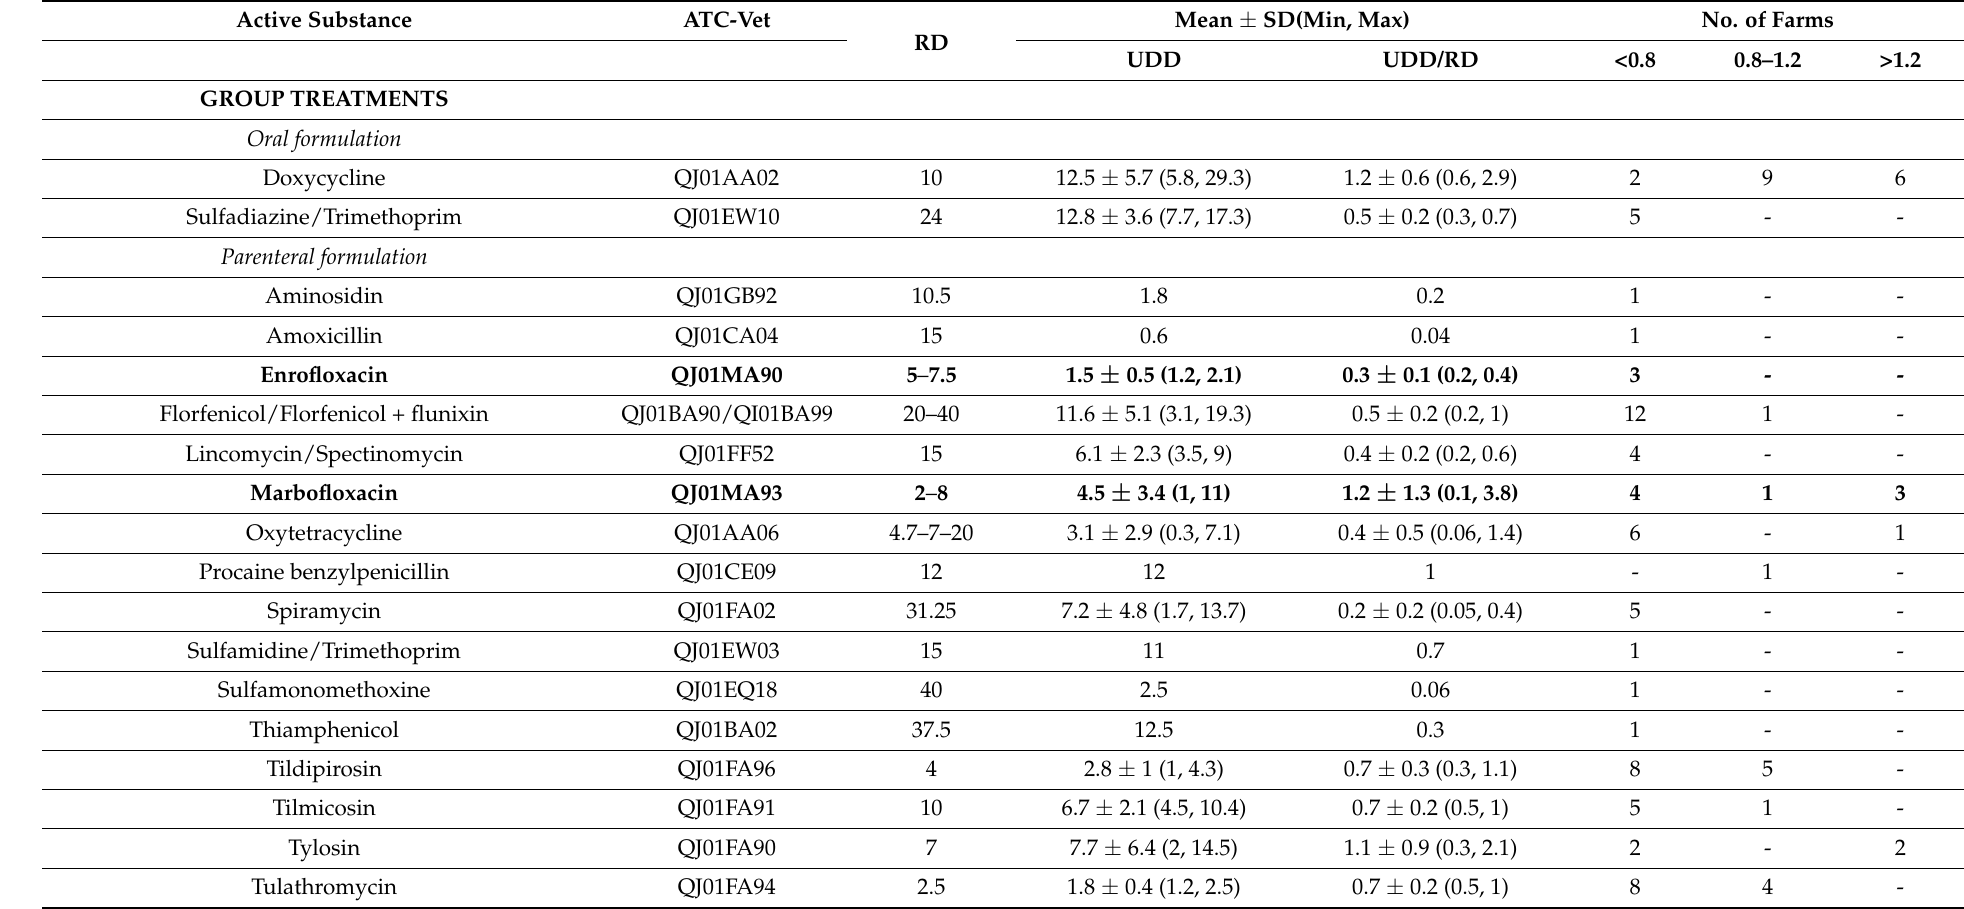
Table 5. Dose (mg/kg) recommended by pharmaceutical manufacturer and dosing ratio of individual and group antimicrobial treatments by route of administration, in 26 Piedmontese fattening operations. More than one recommended dose was reported when more than one commercial formulation of the same active substance was present (e.g., long-acting and normal preparations). RD denotes recommended dose; UDD denotes used daily dose. In bold are the highest priority critically important antimicrobials (HPCIA) in category B according to the European Medicine Agency